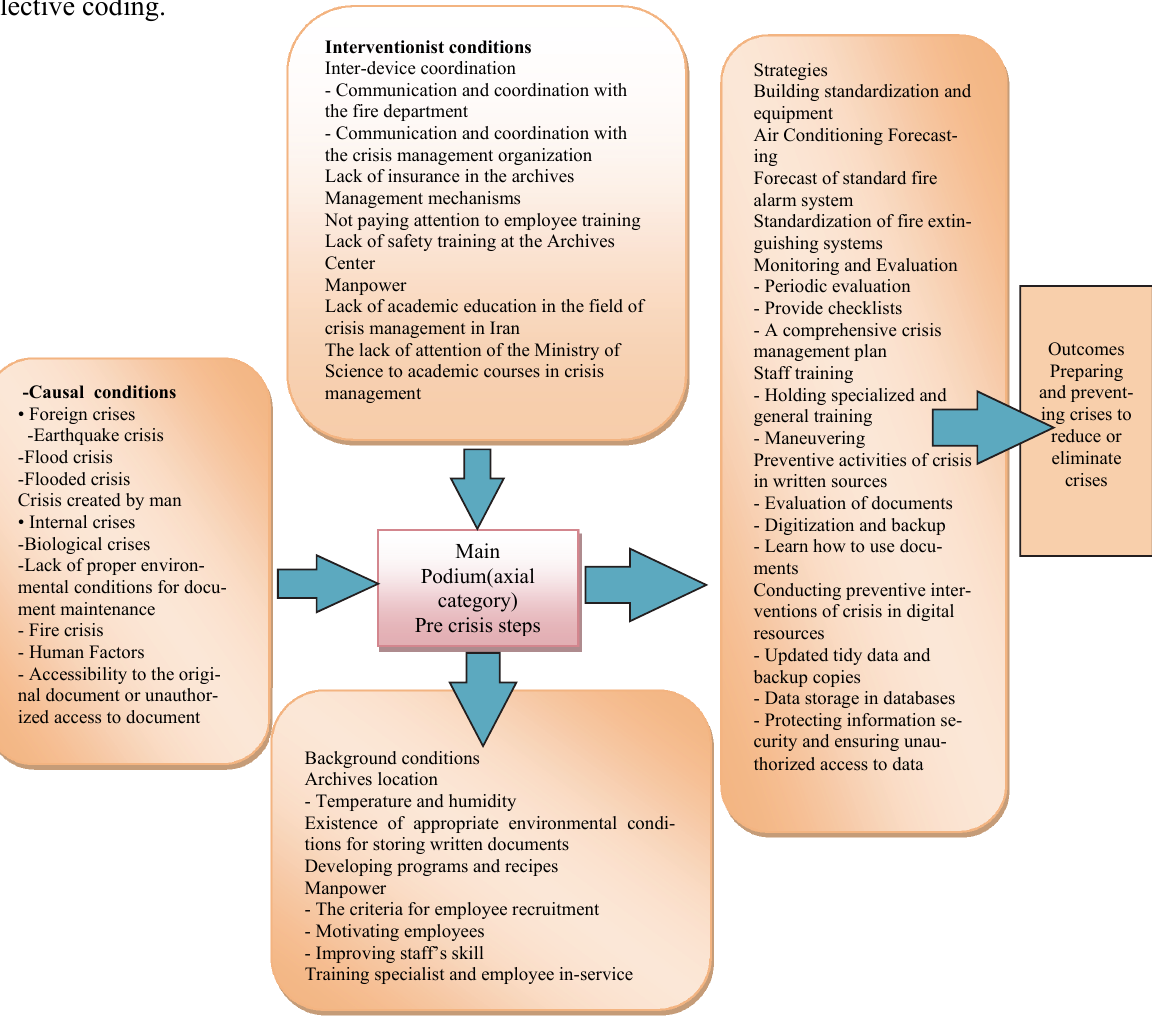
Fig. 2. Pre-crisis management model in Iran’s archival